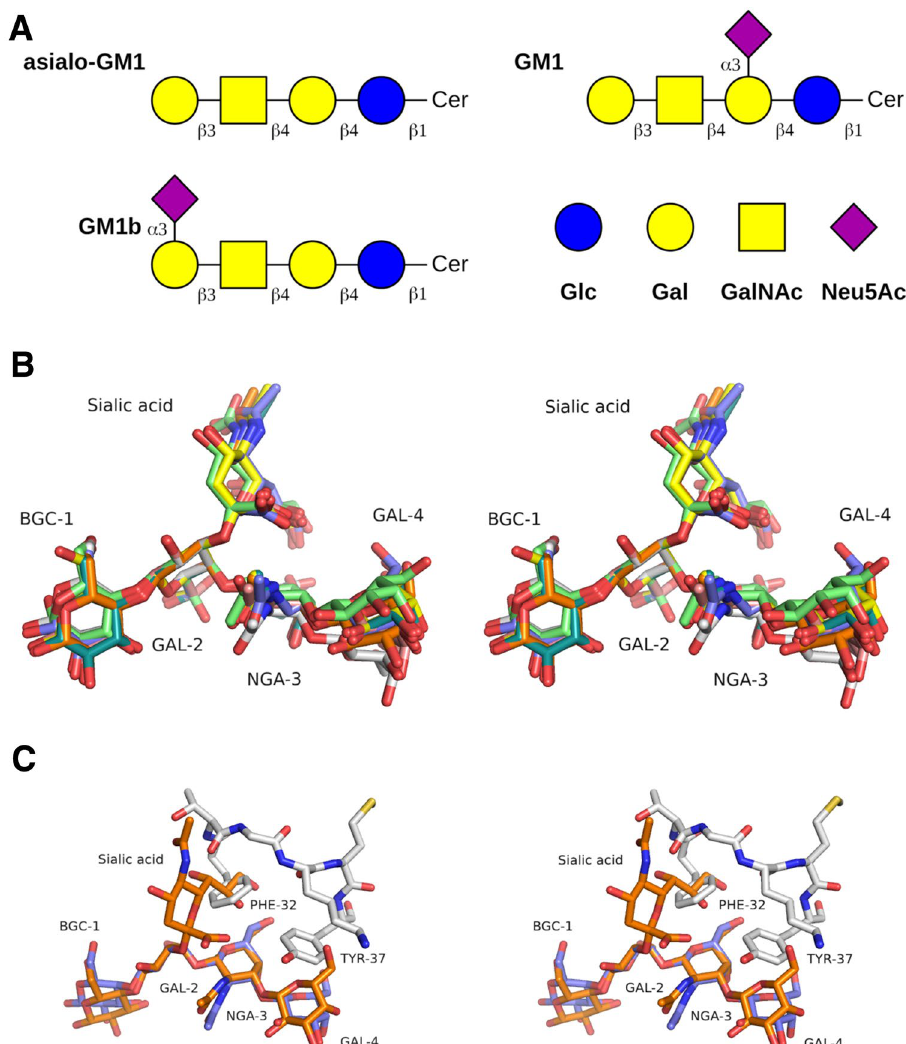
Figure 3. ( A ) The structure of the related glycosphingolipids GM1, GM1b and asialo-GM1. The glucose is linked in each case to ceramide. ( B ) A stereo view of the least-squares overlay of the tetrasaccharide bound to SeviL and the GM1 saccharide found in models from PDB of different lectin complexes. Each saccharide was overlaid by least-squares fit of ten atoms of the Gal-2 residue (omitting O1 and O6). Carbon atoms of asialo-GM1 bound to SeviL are shown in white. Carbon atoms of other complexes are shown with the colours green (endoglycoceramidase I, PDB 5j7z) 35 , orange (polyomavirus genotype 3 VP1, PDB 4x0z) 36 , purple (polyomavirus VP1, PDB 4u60) 37 , dark green (ECX AB5 holotoxin, PDB 4l6t) 38 , pink ( Agrocybe aegerita lectin AAL, PDB 3m3q) 39 , yellow (cholera toxin B-pentamer, PDB 3chb) 40 . ( C ) A stereo view showing the saccharide of GM1 modelled into the binding site of SeviL by overlay of the Gal-2 residue. The sialic acid residue of GM1 clashes strongly with Phe 32 of the